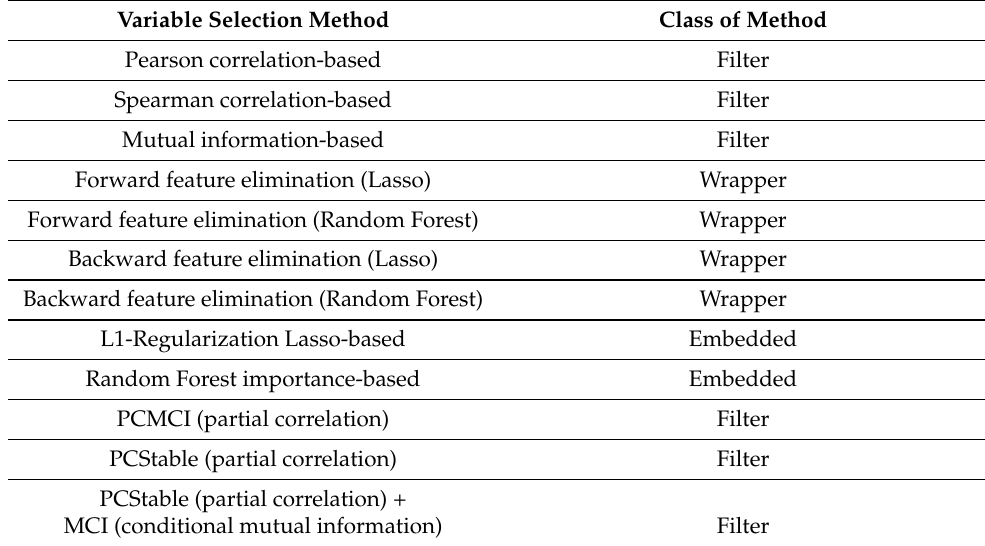
Table 4. Applied variable selection